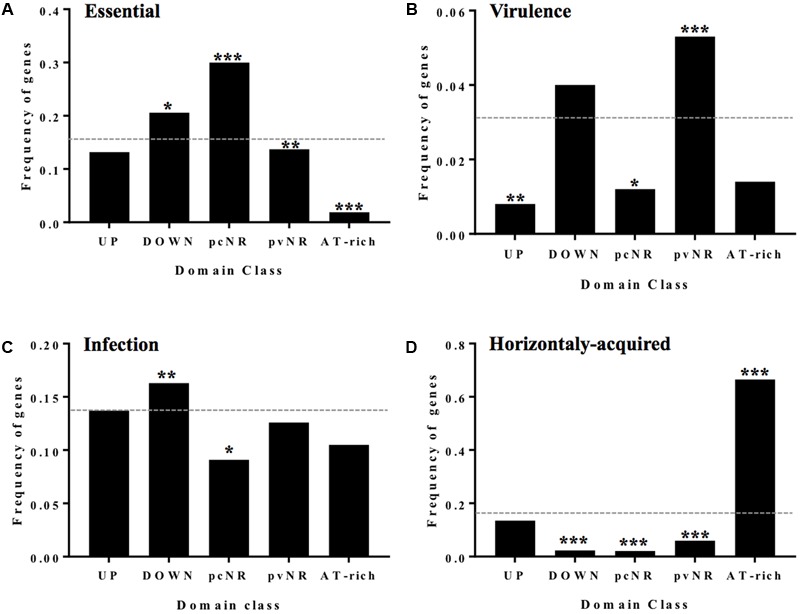
Genes of the different domains have different functionalities. (A) Fraction of essential genes in different domains. (B) Virulence factors. (C) Horizontally acquired genes abundance and domain class. (D) Essential genes for infection by STM. Statistical significance with respect to the genome average (dashed line): ∗P ≤0.05, ∗∗P ≤ 0.01, ∗∗∗P ≤ 0.001. Taken from Martín-Galiano et al. (2017), with modifications.